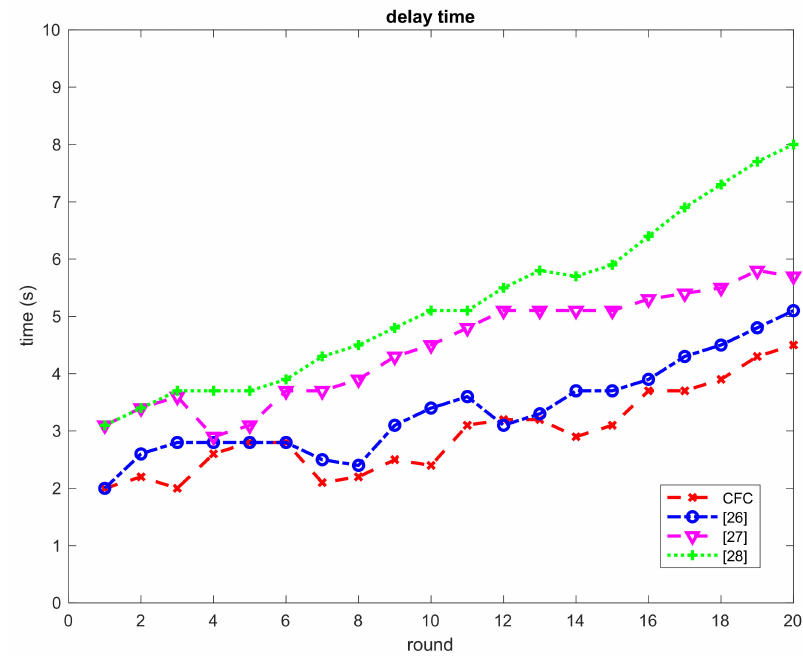
Figure 14. The time delay of newest data